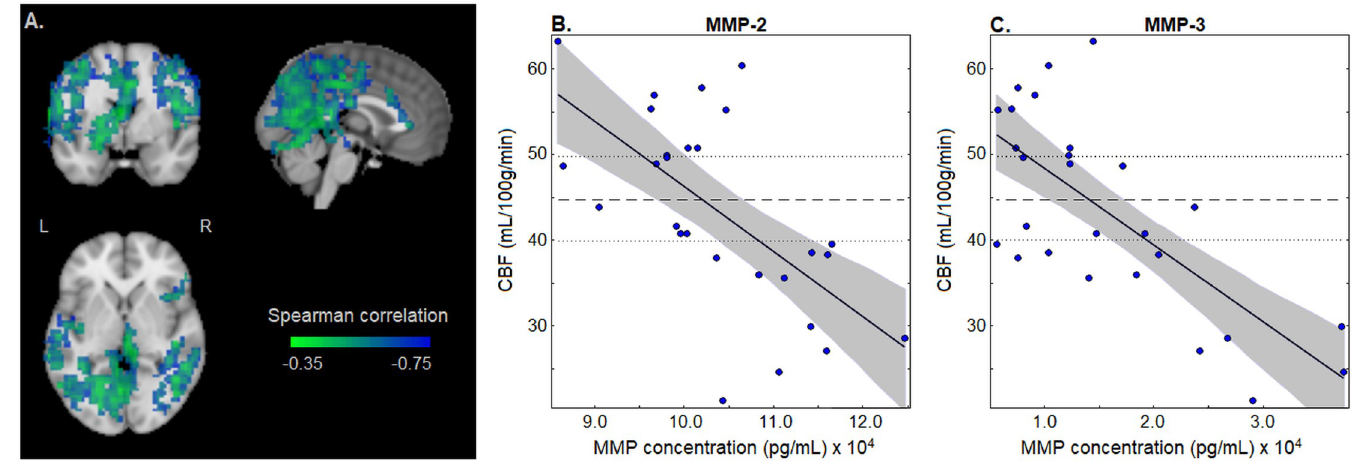
Fig 2. Correlation between matrix metalloproteinase (MMP) concentrations and regional cerebral blood flow (CBF). Results are shown for concussed athletes at early symptomatic injury, and for MMPs significantly correlated with global CBF (MMP-2 and MMP-3; see Fig 1). (A) Brain regions that have significant correlations with the (MMP-2 + MMP-3) composite score. Images are maximum intensity projections, centered on MNI coordinates (x = 0, y = 0, z = 0). The average CBF values of significant brain regions are also plotted against (B) MMP-2 and (C) MMP-3 concentrations. For these plots, the regression line of best fit is in solid black, with shaded bands denoting the bootstrapped 95%CIs. The thick dashed line denotes the mean CBF value for controls, with thin dashed lines enclosing the bootstrapped 95%CI of the mean. https://doi.org/10.1371/journal.pone.0253134.g002 regions. Fig 2B plots MMP-2 concentration against mean CBF, averaged over significant clus- ters in the brain. Linear regression obtains a coefficient b = -7.60x10 -4 (95%CI: -10.48x10 -4 to -5.09x10 -4 ; p < 0.001) and an R 2 of 0.404 (95%CI: 0.189, 0.652), and these clusters have a Spear- man correlation of -0.633 (95%CI: -0.800, -0.308). Fig 2C similarly plots MMP-3 concentration against mean CBF. Linear regression obtains a coefficient b = -8.96x10 -4 (95%CI: -12.27x10 -4 to -6.03x10 -4 ; p < 0.001) and an R 2 of 0.513 (95%CI: 0.246, 0.729), and these clusters have a Spearman correlation of -0.639 (95%CI: -0.853, -0.283). Thus, associations between MMPs and CBF exhibit some spatial specificity, with greatest effects confined to posterior and dorsal brain regions. Supplemental analyses of cluster-specific CBF found no significant differences in regression coefficient values, compared to the all-cluster results. One cluster (cluster #8 in Table 2, right inferior frontal area) had a slightly higher coefficient value when regressing CBF against MMP-2 ( p = 0.016) with a coefficient difference Δ = 3.65x10 -4 (95%CI: 0.96x10 -4 to k 5.75x10 -4 ) but it was non-significant at an FDR of 0.05. All other clusters showed minimal